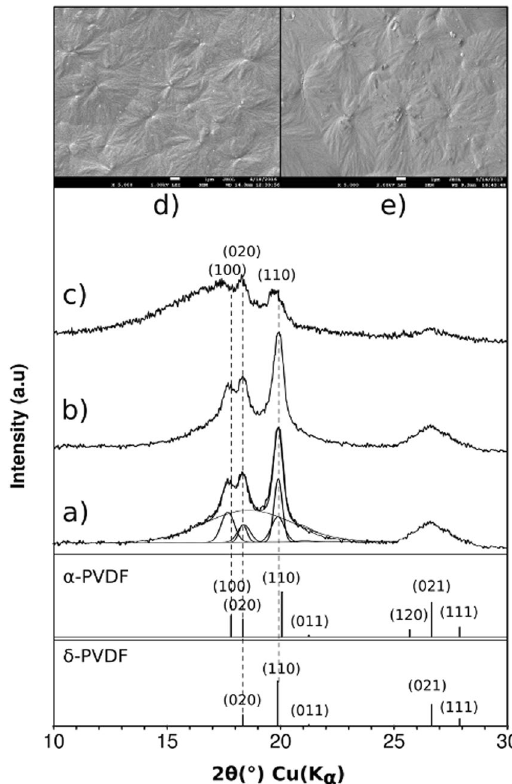
Figure 1. Room temperature X-Ray diffraction patterns of the poly(vinylidene fluoride) membrane indexed as α -phase and δ -phase: ( a ) before and ( b ) after hysteresis measurement; ( c ) at 170 °C. SEM micrographs ( d ) before and ( e ) after hysteresis measurement.